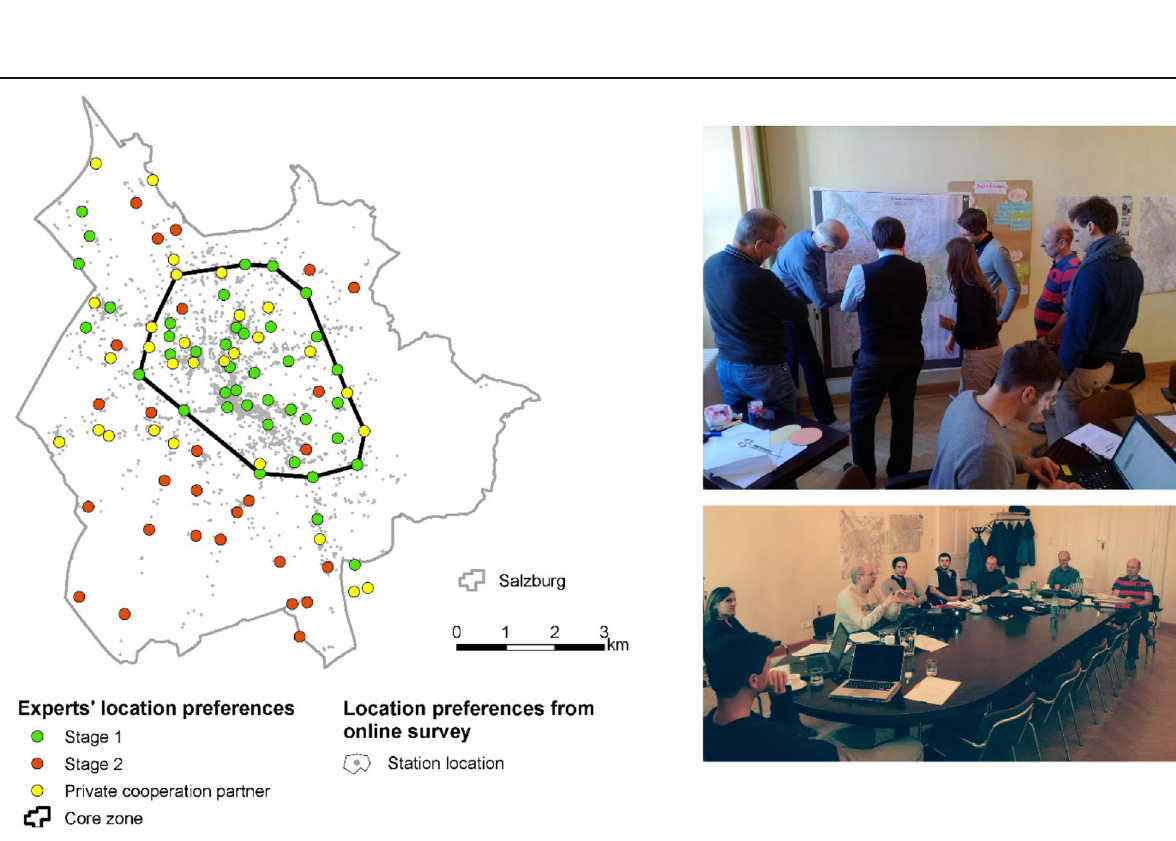
Fig. 8 Result of the expert workshop: definition of a core zone and two stages of